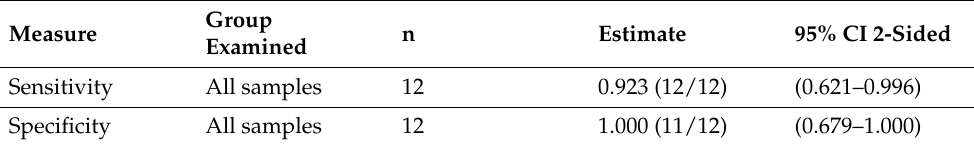
Table 1. AKRO-QC-ICG imaging Pluronic F-127 hydro-gel#30 detects the human breast cancer tissue in vivo with a high sensitivity and specificity in nude orthotopic mouse models.